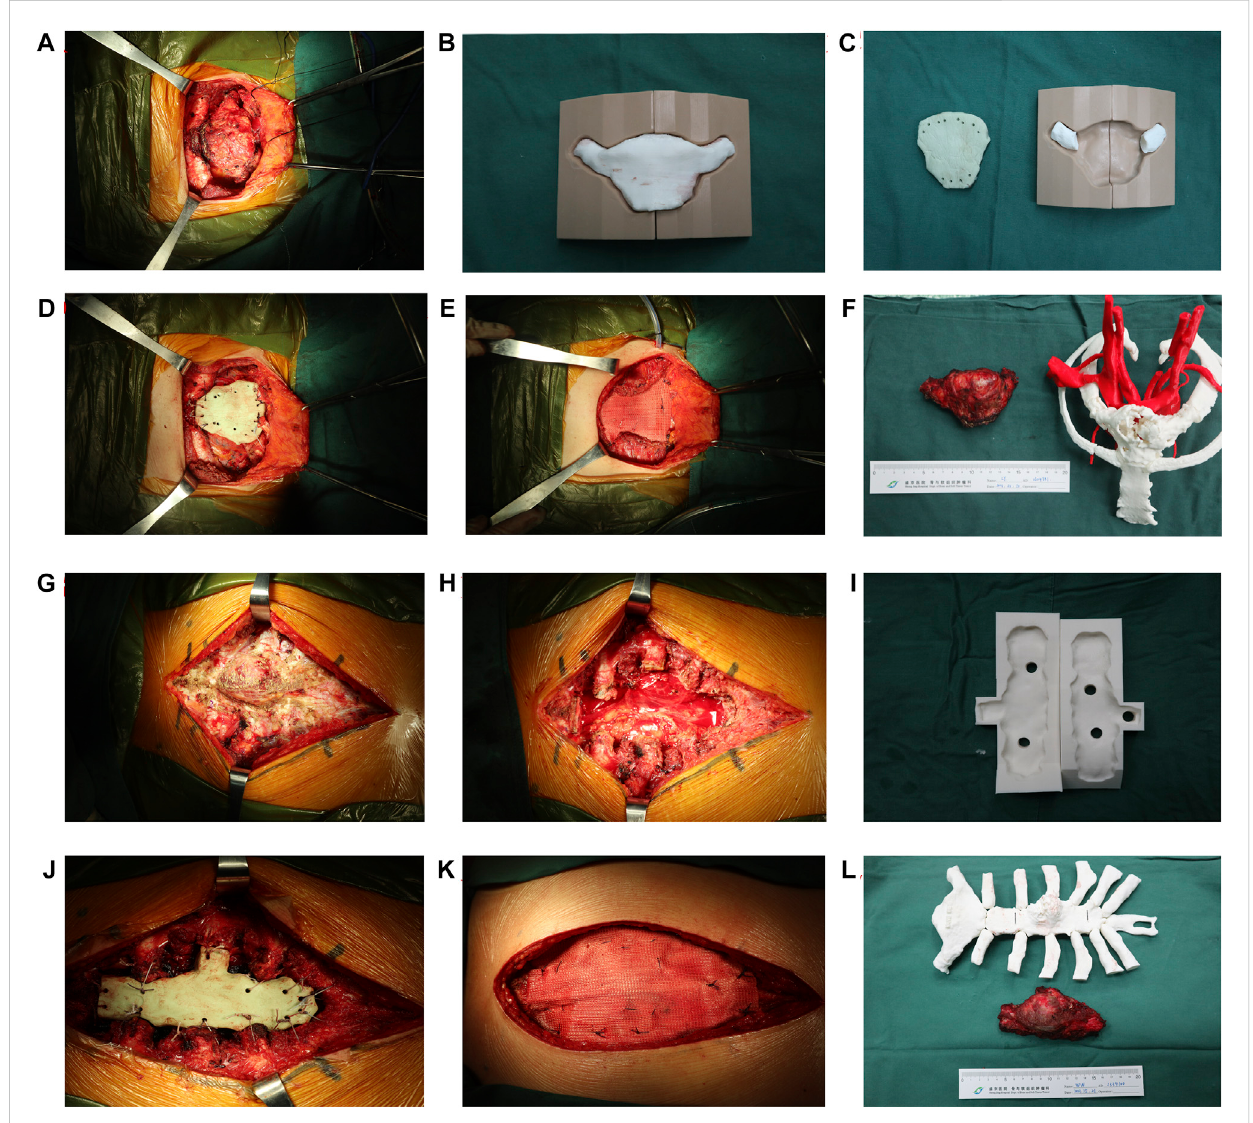
FIGURE 2 Surgical procedure of sternal tumour resection and reconstruction. (A – F) The female patient. (A) The lesion was exposed and separated. (B – C) Fabricationofsternalprosthesisby3D-printing. (D – E) A “ Sandwich ” cementprosthesisisimplantedinchestdefectregion. (F) Theresectedspecimenand bonecementprosthesiswerecomparedwiththe3D-printingmodel. (G – L) Themalepatient. (G – H) Thelesionisexposedandremoved. (I) Fabricationof the sternal prosthesis by the 3D-printing mould. (J – K) A “ Sandwich ” cement prosthesis is implanted in the chest defect region. (L) The resected specimen and bone cement prosthesis as compared to the 3D-printing